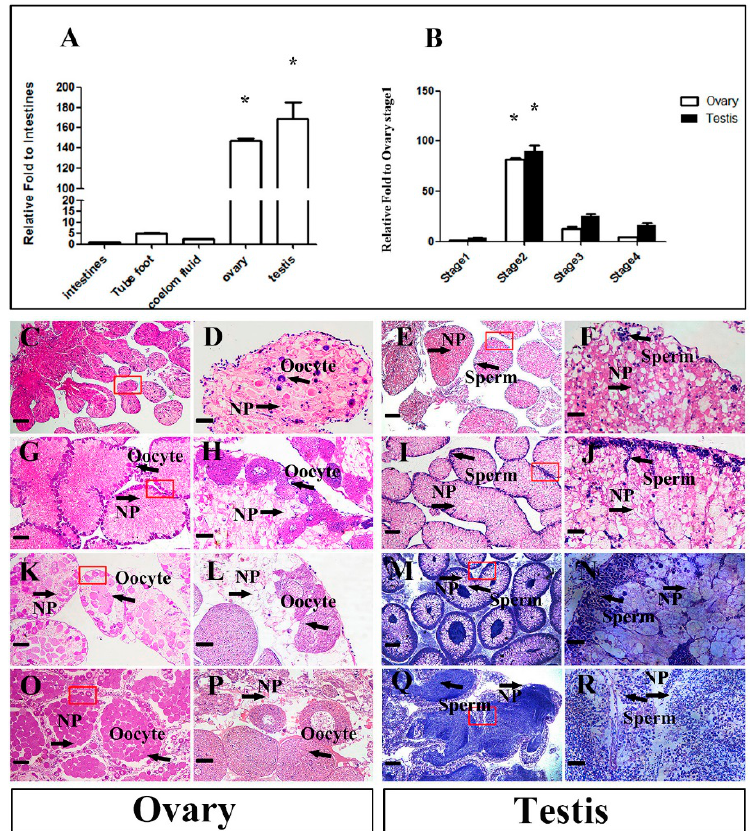
Figure 3. Mnnanos2 expression in adult tissues and gonadal development stages. ( A ) RT-qPCR analysis of nanos2 expression in different adult tissues. Ubiquitin was used as the control. The expression of Mnnanos2 in Intestines was set to 1. Each bar represents mean ± standard deviation (SD) from three to five individuals. Tukey’s test was used to determine statistical analysis. Asterisks (*) indicate significant differences ( p ≤ 0.05) between other tissues and intestines. ( B ) RT-qPCR analysis of nanos2 expression at different gonadal development stages. Ubiquitin was used as the control. The expression of Mnnanos2 at Stage 1 was set to 1. Each bar represents mean ± SD from three individuals. Data are from three independent experiments. Asterisks (*) indicate significant differences ( p ≤ 0.05) between Stage 2–4 and Stage 1 determined by Tukey’s test. ( C , G , K , O ) Histological detection of the ovary at Stage 1–4. ( E , I , M , Q ) Histological detection of testis at Stage 1–4. The red boxed areas on the left are shown on the right at higher magnification ( D , H , L , P , F , J , N , R ). NP: nutritive phagocytes. Bar: ( C , G , K , O , E , I , M , Q ) 200 µm, and ( D , H , L , P , F , J , N , R ) 25 µm.